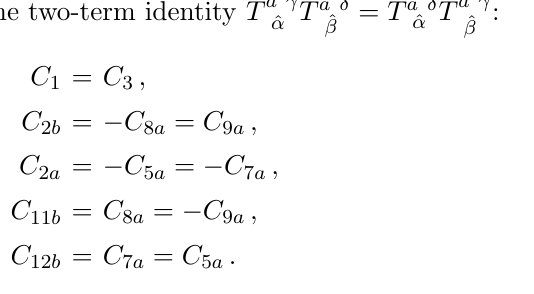
(cid:0) (cid:1) (cid:0) P (cid:1) Q (cid:17) r j i i = (cid:14) 4 . The numbering of the graphs follows the i i